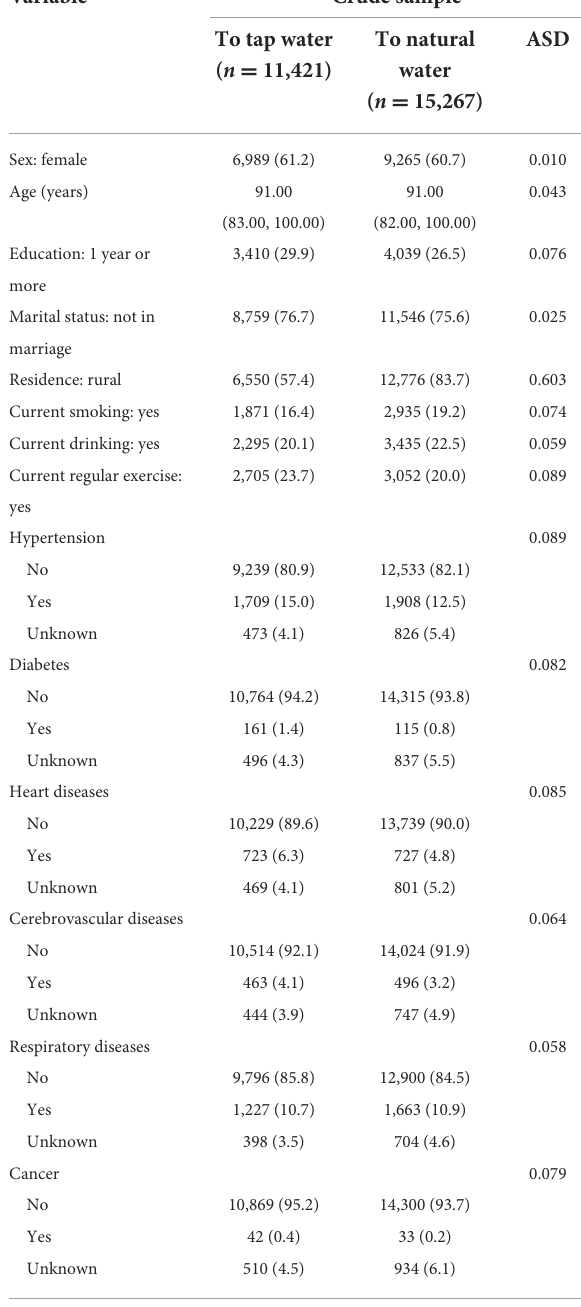
TABLE 1 Baseline characteristics stratified by baseline drinking water